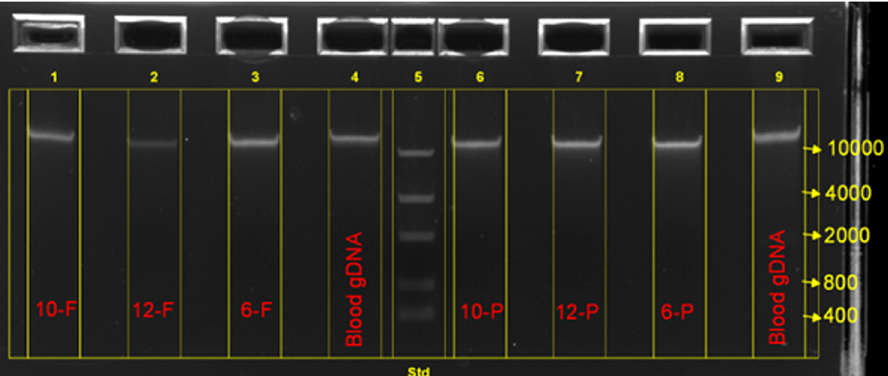
Fig. 1 Electropherogram showing the quality of genomic DNA derived from dried blood spot samples. Image of electrophoresis of genomic DNA from dried blood samples (DBS) 10-FTA, 12-FTA, 6-FTA, 10-PC, 12-PC, 6-PC and blood in a 0.8% agarose gel. Molecular weight standards are shown (nucleotides). A single high-molecular weight band is observed, with no apparent DNA degradation.